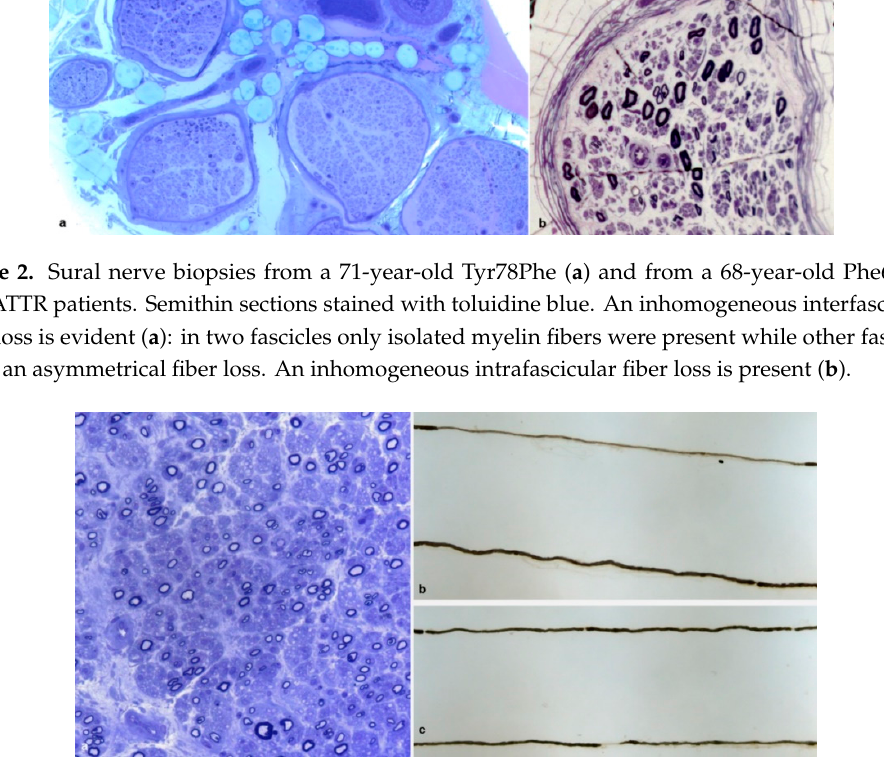
Figure 3. Sural nerve biopsy from a 69 ‐ year ‐ old Tyr78Phe patient ( a ): semithin section stained with toluidine blue. A moderate fiber loss is observed. Many fibers are surrounded by thin myelin sheath. Several regenerating clusters are present. Teased fibers examination from a 44 ‐ year ‐ old patient with Glu89Gln ( b ) and from a 73 ‐ year ‐ old patient with Phe64Leu ( c ). A segmental demyelination is present in b while a paranodal demyelination is noted in c .